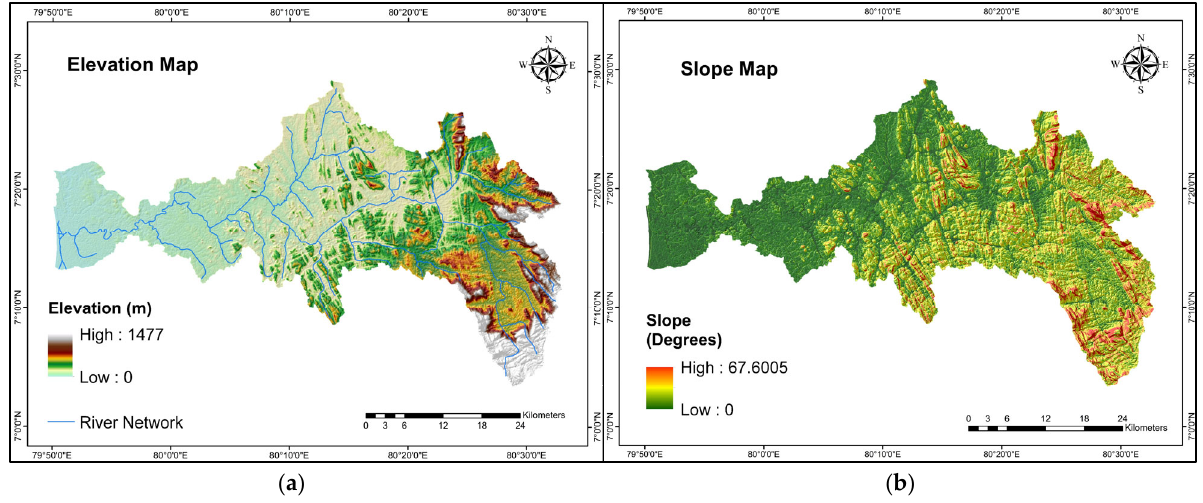
Figure 4. ( a ) Elevation map and ( b ) Slope (Degrees) map of the MORB.